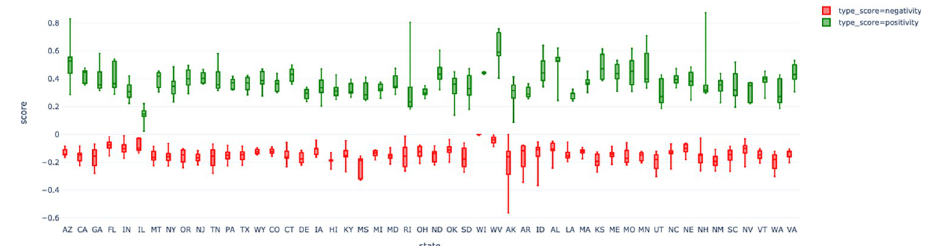
Fig 7. Average (standard deviation and 95% confidence intervals) for positivity and negativity per state during